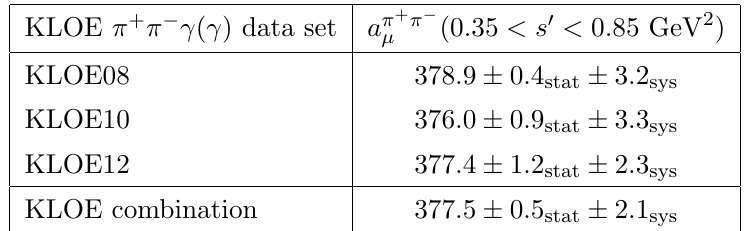
(0 : 35 < s 0 < 0 : 85 GeV 2 ) from the (cid:22) are given in units (cid:22)